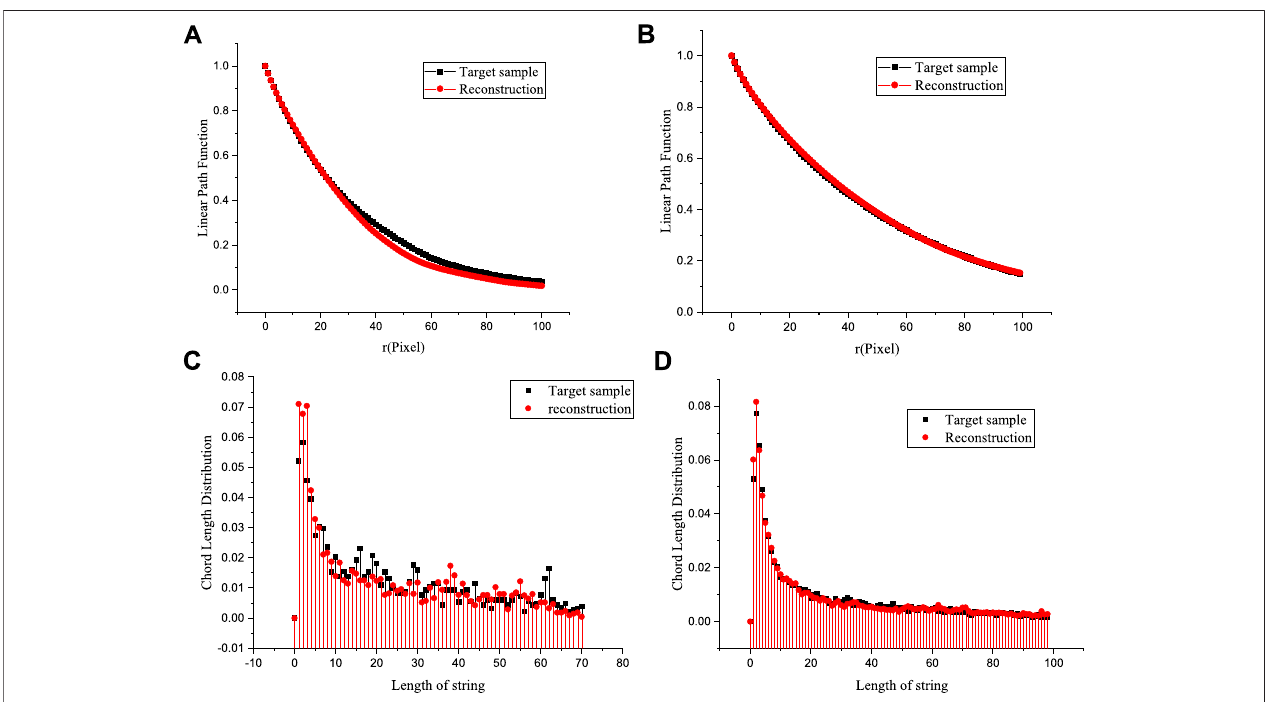
FIGURE 12 | Comparison of linear path function (A – B) and chord length distribution function (C – D) between target systems and reconstructed structures for different mineral